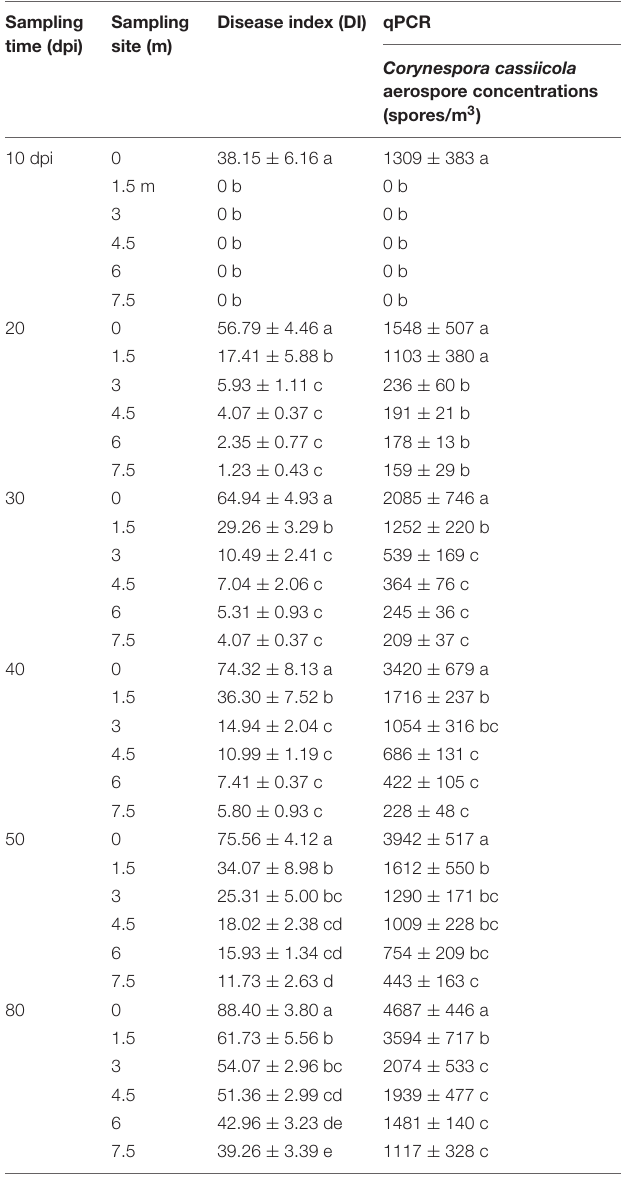
C. cassiicola aerospore concentrations are expressed as the mean ± standard deviation (SD) of data from four sampling points. Three independent experiments were performed between November 2018 and February 2019. Columns labeled with different letters indicate statistically significant differences (P <